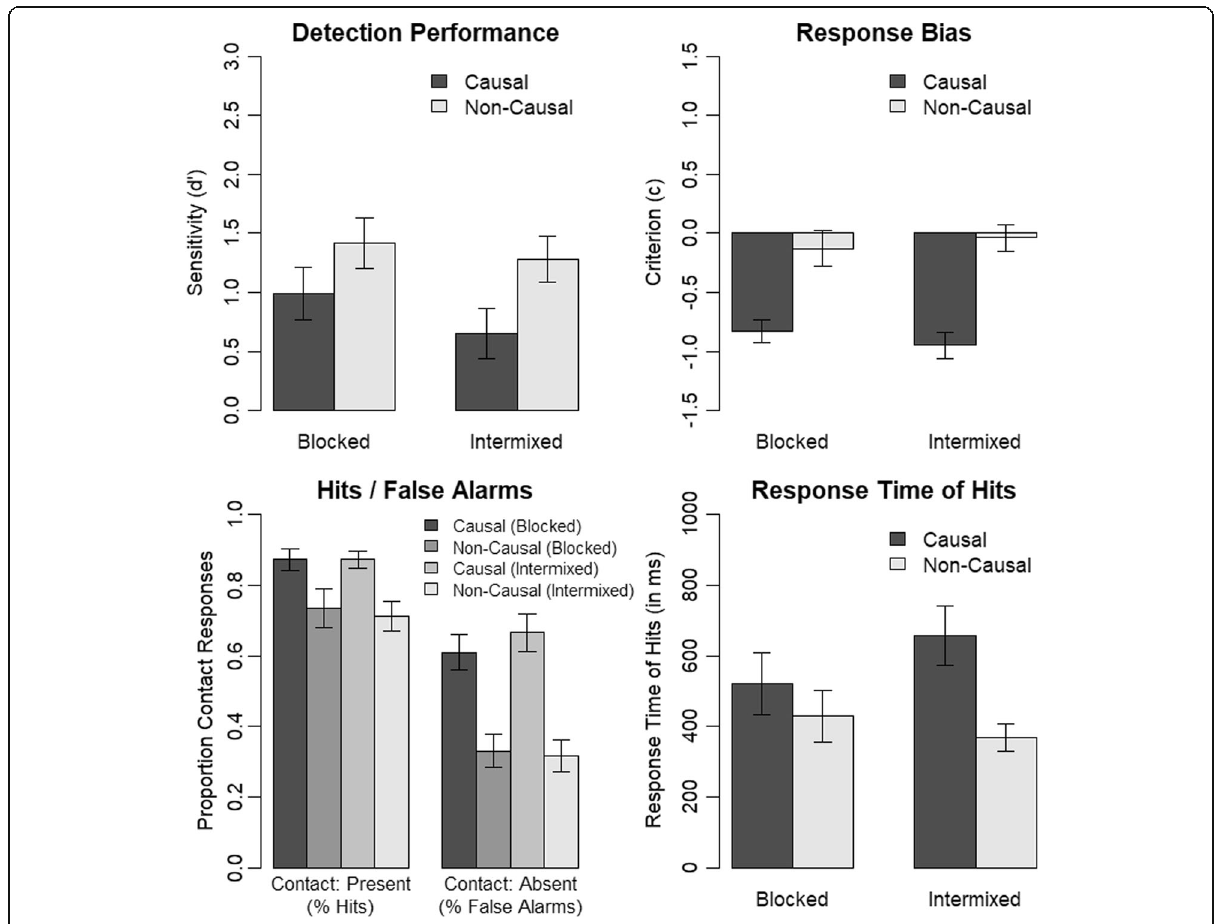
Fig. 5 Results of Experiment 3. Error bars indicate the standard error of the